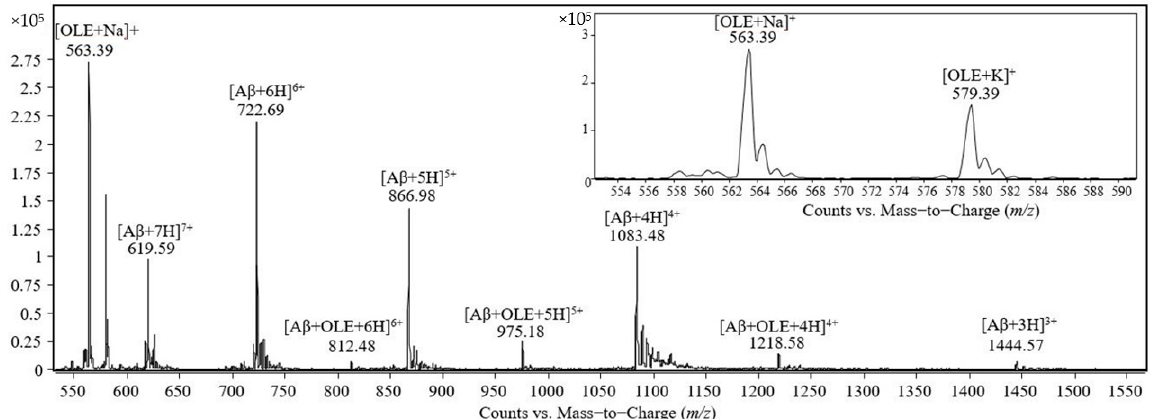
Figure 2. Mass spectrum obtained by ESI-triple quadrupole analysis of the equimolar solution containing A β (1–40) and oleuropein at 50 pmol/ μ L in 0.47 mM ammonium acetate, pH 7.4, after incubation for 30 min at room temperature.